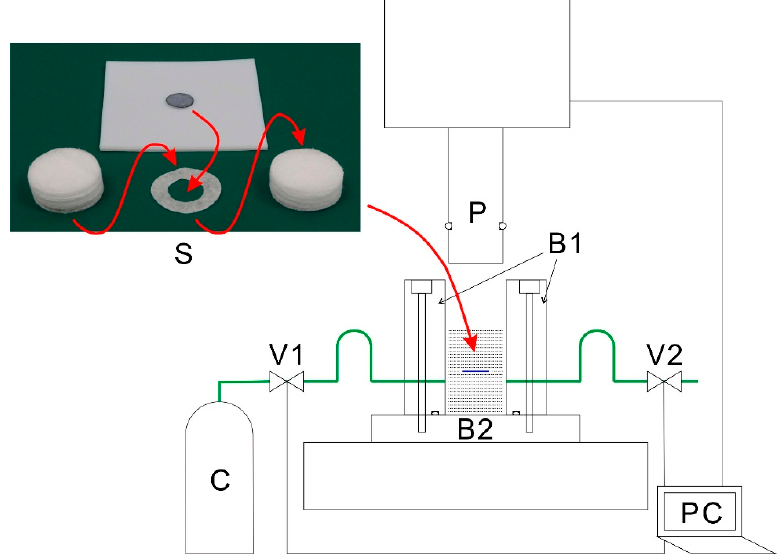
Figure 1. Schematic illustration of the cross-section of the high-pressure vessel used for CO 2 -assisted polymer compression. B1: Body of the high-pressure vessel, B2: Base of the high-pressure vessel, C: CO 2 cylinder, P: Piston, PC: Laptop computer, S: Sample, V1: Intake valve, and V2: Exhaust valve.